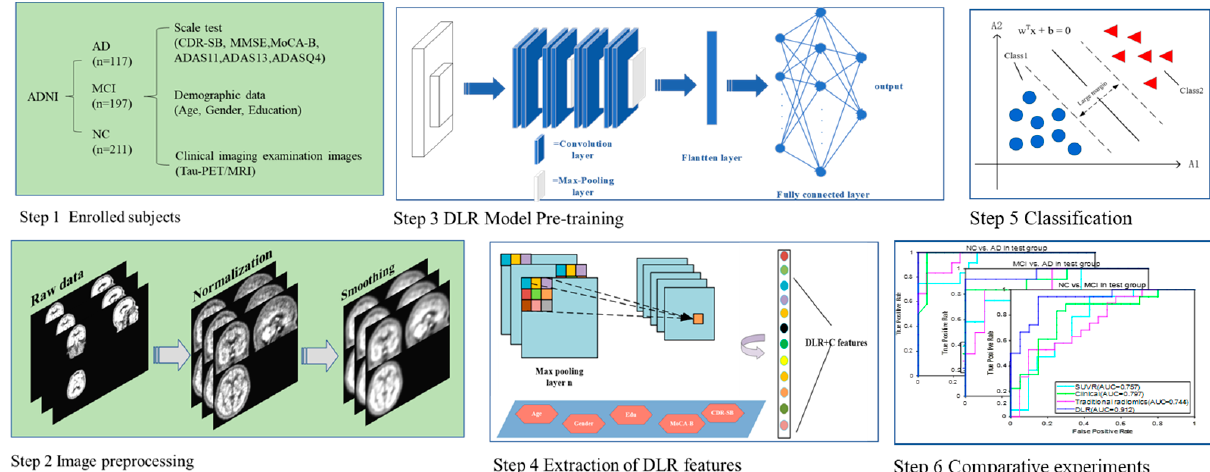
Figure 1. The whole experimental process in this study.